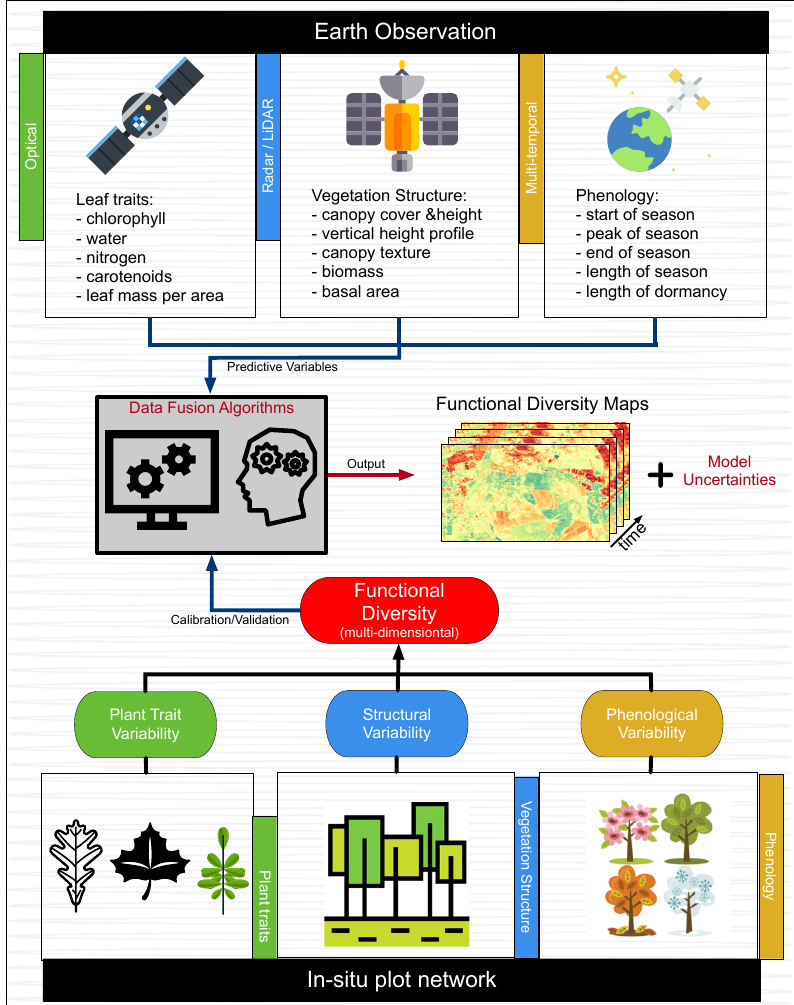
Figure 3. A Conceptual Workflow for Upscaling Plant FD Using Satellite Measurements. In the bottom panels, there are variations in plant leaf traits, vegetation structure, and phenology within a plant community that can be directly measured on the ground, from which a multi-dimensional FD measure can be computed. In the upper panels, there are satellite measurements that are capable of measuring leaf, structural, and phenological traits. Taking the in-situ FD and satellite measurements as input, innovative statistical models (e.g., machine learning) can be calibrated for mapping plant FD at regional or even global scales.